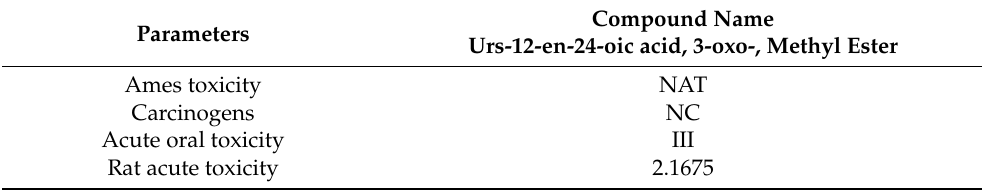
Table 10. Toxicological properties of the uppermost bioactive on AKT1 (PDB ID: 5KCV) in MDT.